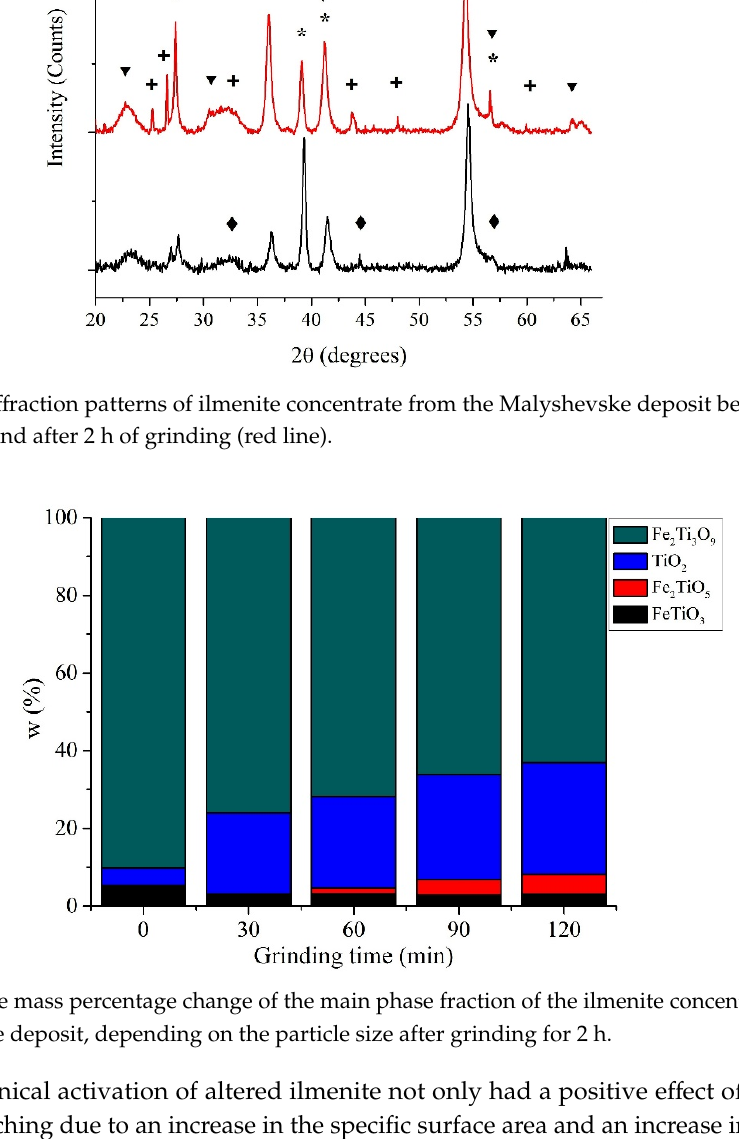
Figure 2. Diffraction patterns of ilmenite concentrate from the Malyshevske deposit before grinding (black line) and after 2 h of grinding (red line).